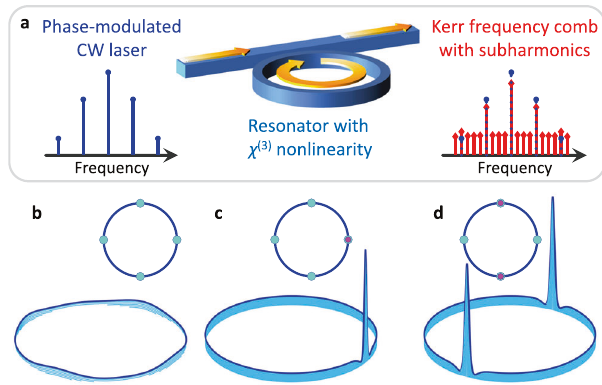
Fig. 1 Dissipative discrete time crystals (DTCs) in an optical Kerr- nonlinear resonator. a Schematic showing a typical ring resonator side- coupled to an access waveguide. Modulation of the continuous-wave (CW) laser pump at an integer multiple of the resonator free spectral range (here for ω M = 4 D 1 ), creates sidebands for the laser tone (blue spikes with fi lled circle tips on the left). This drive creates a broader array of phase-locked frequency harmonics in the cavity, corresponding to a train of temporal solitons. For certain arrangements, these solitons break the discrete time- translation symmetry de fi ned by the drive periodicity (here one-fourth the round-trip time, T R /4), realizing a DTC with signature subharmonics (red spikes with fi lled diamond tips seen on the right). b – d The intra-cavity waveform without solitons ( b ), and with 1 and 2 soliton peaks, giving rise to a 4-DTC ( c ) and a 2-DTC ( d ). The spectrum in a with harmonics fi lling all free spectral ranges between drive sidebands (red spikes between dotted blue ones) is the frequency spectrum of the waveform depicted in c . To better visualize the background modulation induced by pump phase modulation, vertical axis data in ( b ) is limited to (0.5, 1) in normalized units. This modulation is small ( ≈ 10 times) compared to the soliton peak power and hence hardly visible in c , d